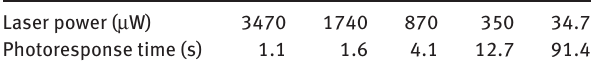
nanoparticles (NPs) 2 = 0 V, gs